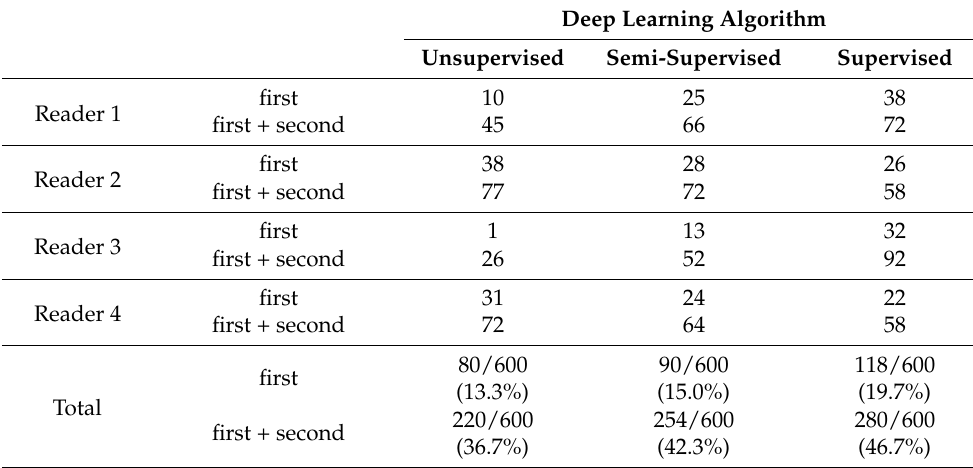
Table 3. Comparisons of the selected proportions of the three deep learning algorithms.